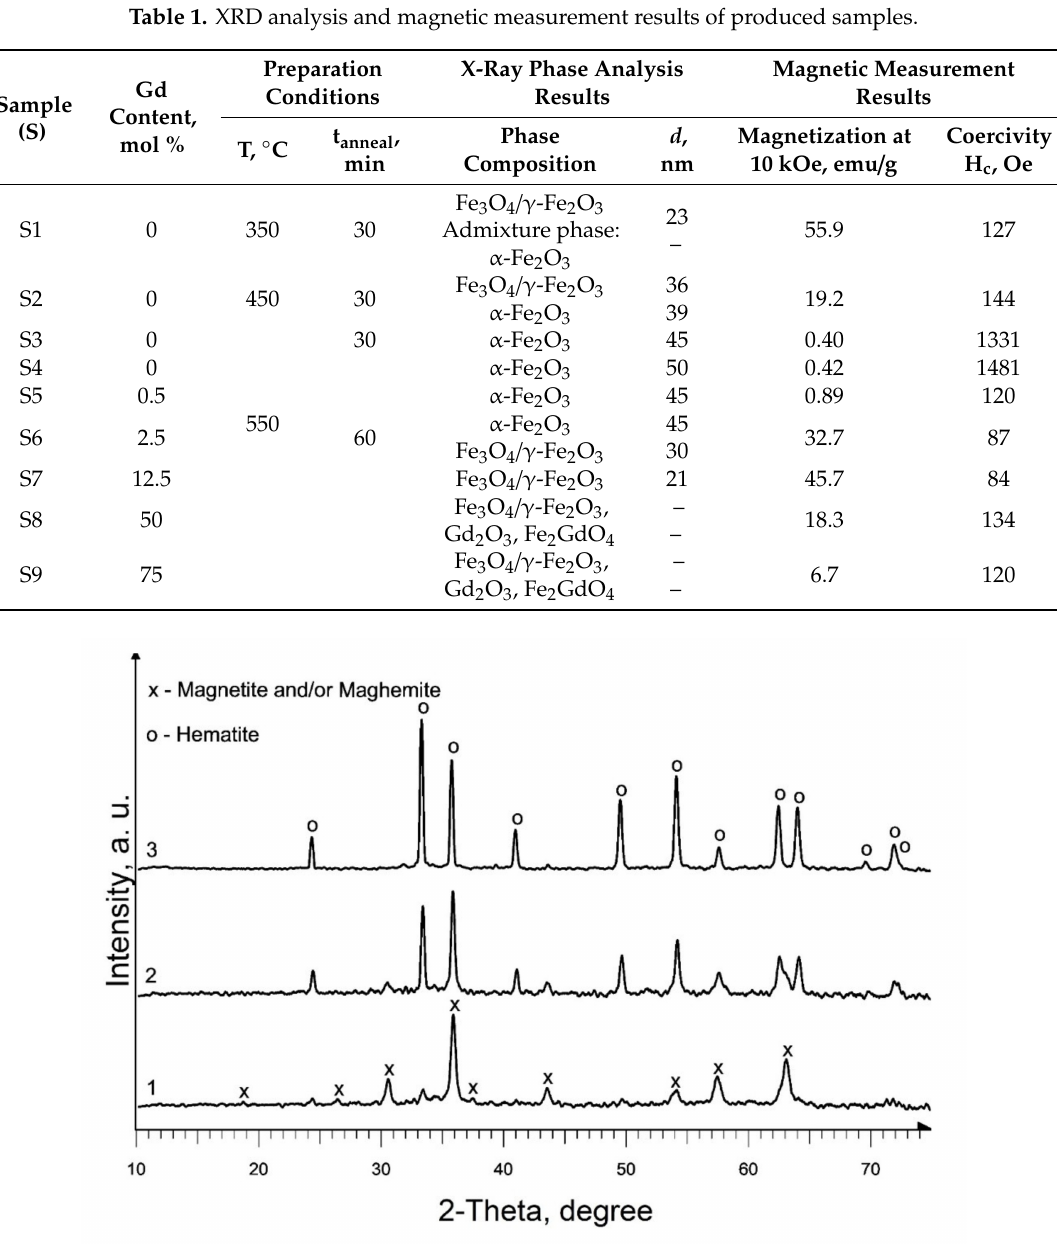
Figure 2. XRD patterns of produced pure iron oxides samples: 1—S1; 2—S2;